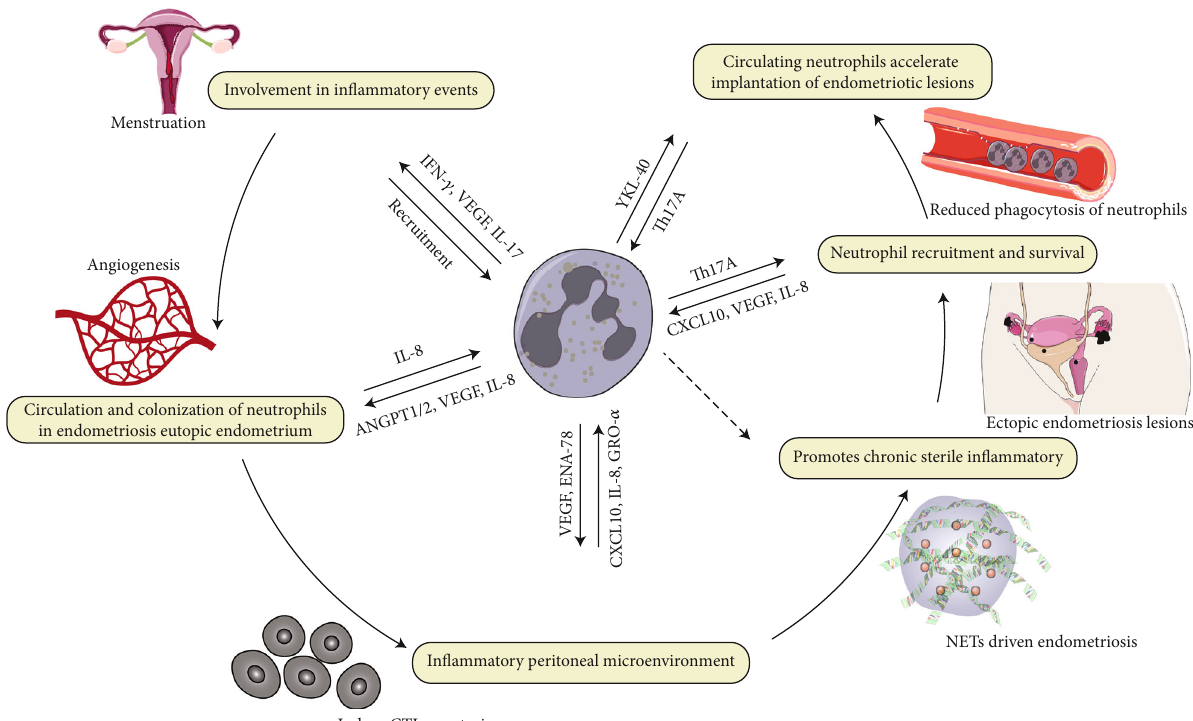
Figure 3: Mechanisms of neutrophil-mediated pathophysiology of endometriosis. The number of neutrophils increases signi fi cantly in the premenstrual period and participates in the shedding and repair of the endometrium. Endometriosis eutopic endometrium has a high neutrophil count, which overexpresses VEGF, IL-8, and ANGPT1/2, resulting in dysregulation of angiogenic activity and further tissue shedding to form ectopic endometrial lesions, shaping the in fl ammatory peritoneal microenvironment. A vicious cycle of recruiting neutrophils, secreting cytokines and growth factors, and promoting apoptosis of cytotoxic T cells is further formed. In this process, the increase of neutrophils in the circulating blood is accompanied by the weakening of phagocytosis, and pathophysiological pathways like NETs are also involved, generating a highly complex and dynamic microenvironment. IFN- γ : interferon- γ ; VEGF: vascular endothelial growth factor; IL-17: interleukin-17; IL-8: interleukin-8; ANGPT1/2: angiopoietin 1 and 2; ENA-78: epithelial neutrophil activating peptide-78; CXCL10: interferon-gamma-induced protein-10; GRO- α : chemokine